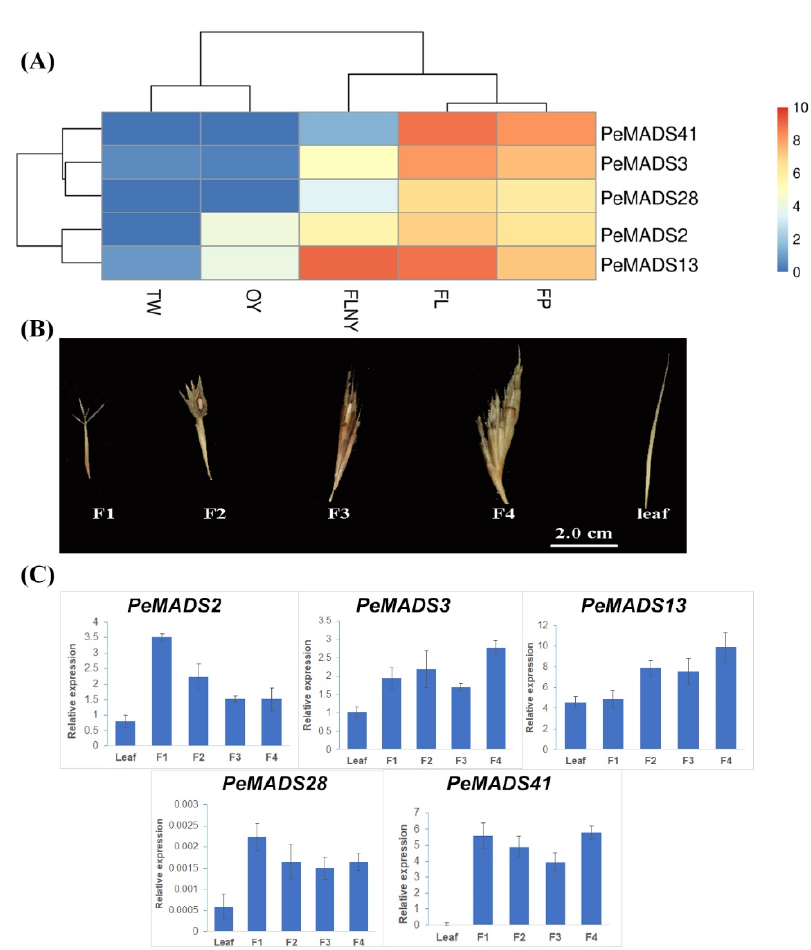
Figure 2. The expression pattern of PeSQUA -like genes. ( A ) The expression levels of PeSQUAs during the transition from vegetative to reproductive growth. TW: leaves from 3-week-old seedlings, OY: leaves from 1-year-old plants, FLNY: leaves from plants that will flower in the next year, FL: leaves from flowering plants, and FP: flower florets. ( B ) The bamboo inflorescence development was divided into four stages: the first floral bud formation (F1), the initial stage of inflorescence development (F2), maturation of inflorescence (F3), and anthesis (F4). The leaf tissues (leaf) from the non-flowering plant. ( C ) qPCR analysis of PeSQUAs at different flowering stages. NTB or TIP41 was used as a reference gene; mean ± SD of three biological replicates is